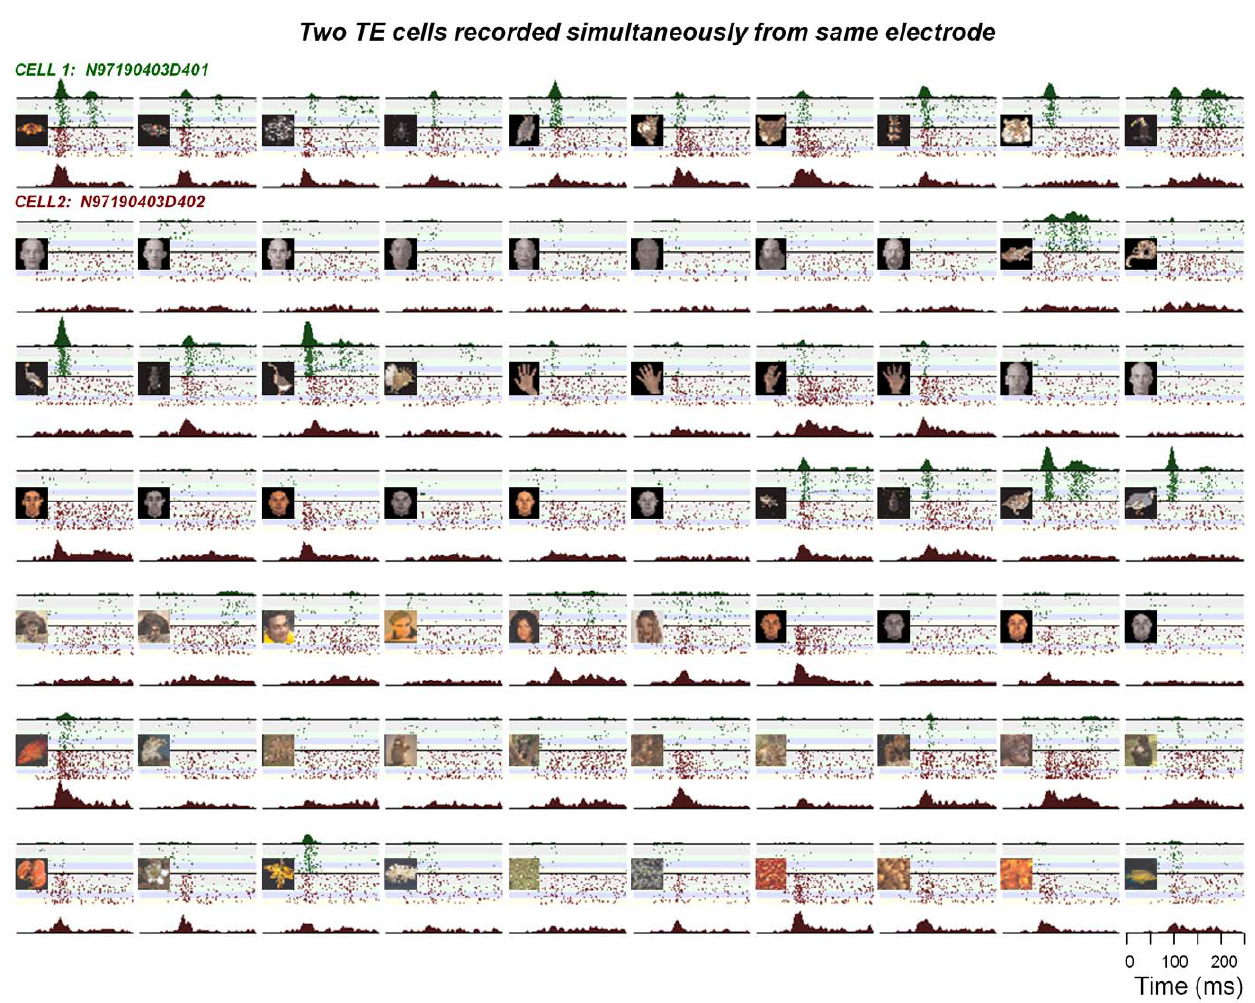
Figure 5. Responses of two area TE neurons to 65 stimuli. The two neurons were recorded simultaneously from the same electrode over a period of four days. The stimuli, presented at time=0, are shown in the left portion of each panel. Despite the proximity of the two cells, their responses, including their basic stimulus selectivity, remained distinct over the recording sessions. Accumulated peristimulus time histograms are shown above and below the rasters of the two neurons.